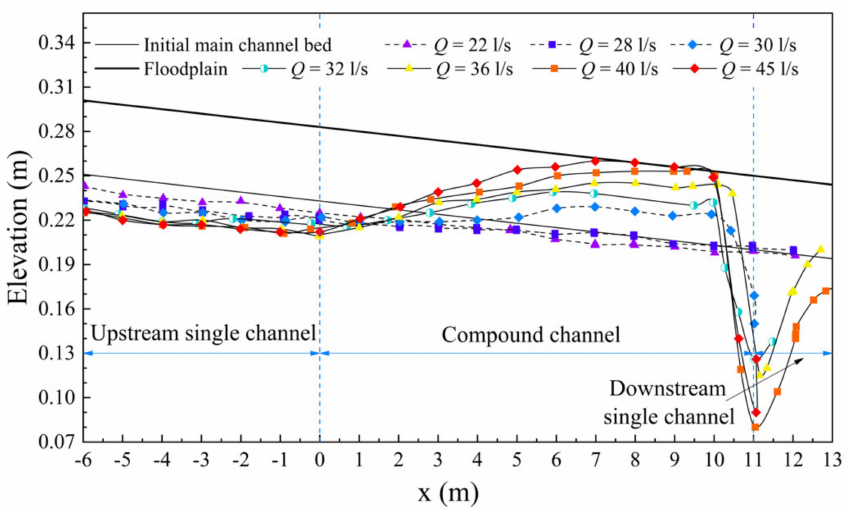
Figure 7. Longitudinal bed profile along the centerline of the main